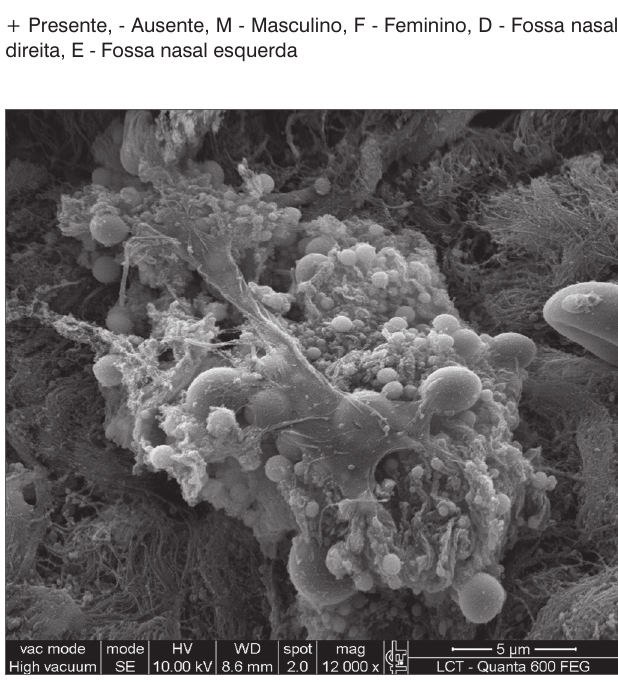
Figura 1a. Biofilme bacteriano (12.000x)